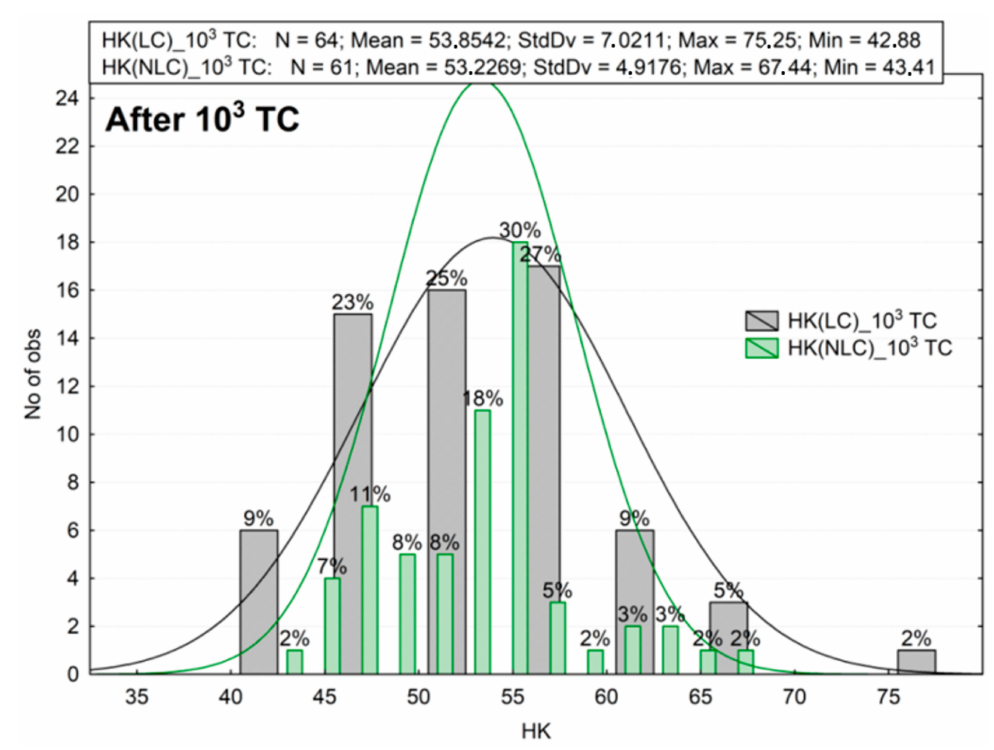
Figure 6. The results of Knoop hardness measurements for B-F after thermocycling (TC). LC—light- cured surface of sample (top side of sample), NLC—non-light-cured surface (bottom side of sample), HK—Knoop